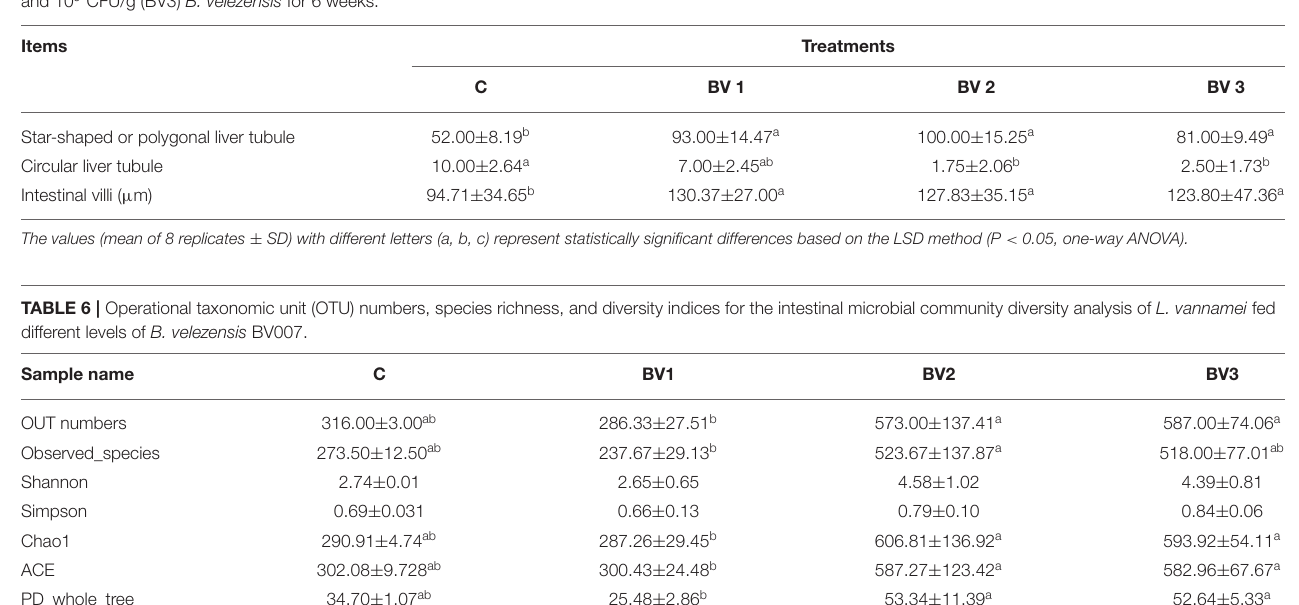
TABLE 5 | Statistics of the morphology and structure of hepatopancreas and midgut of L. vannamei fed diets containing 0 CFU/g (C), 10 5 CFU/g (BV1), 10 7 CFU/g (BV2), and 10 9 CFU/g (BV3) B. velezensis for 6 weeks. Items